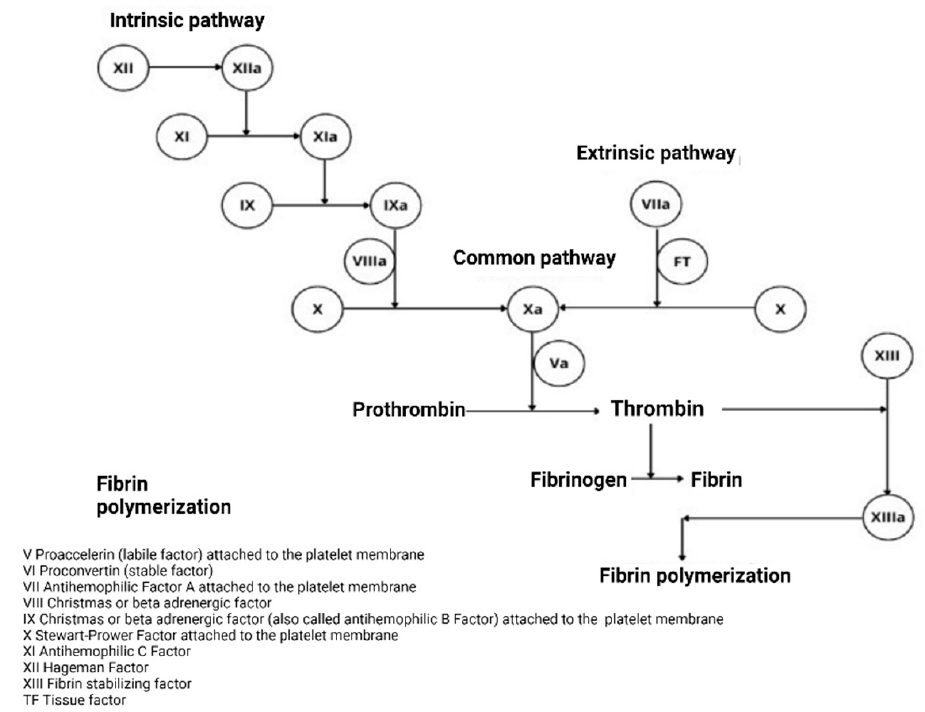
Figure 1. Classical concept of the coagulation cascade. Note: This figure presents the classical theory of coagulation based on two pathways (intrinsic and extrinsic) that converge in a common pathway. Mann KG, et al. [4].